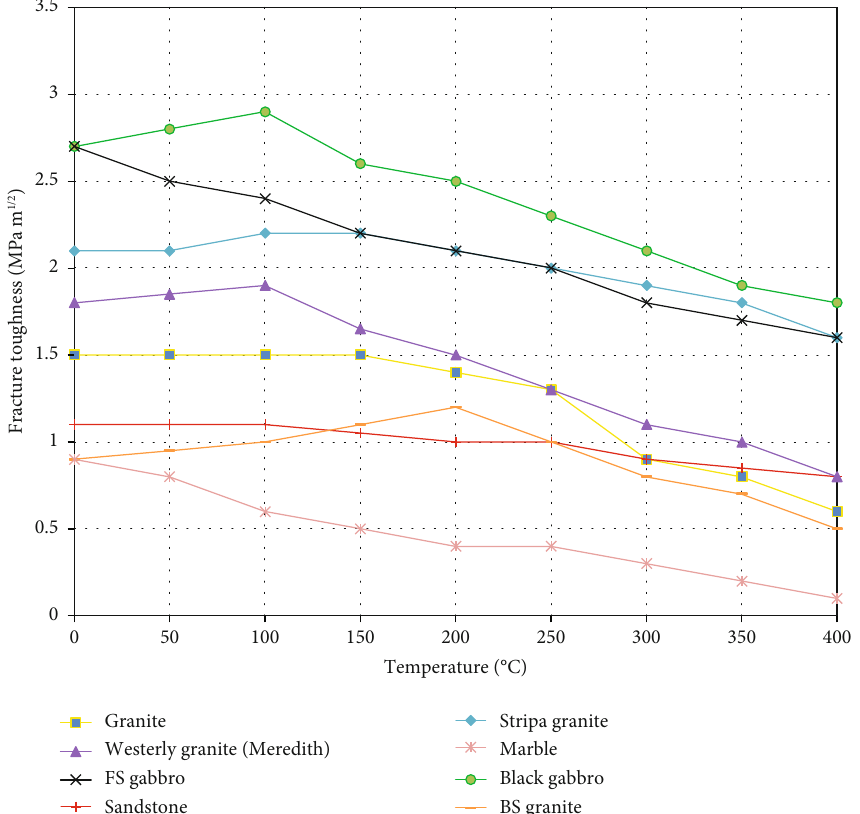
Figure 7: Temperature a ff ects the fracture toughness of di ff erent